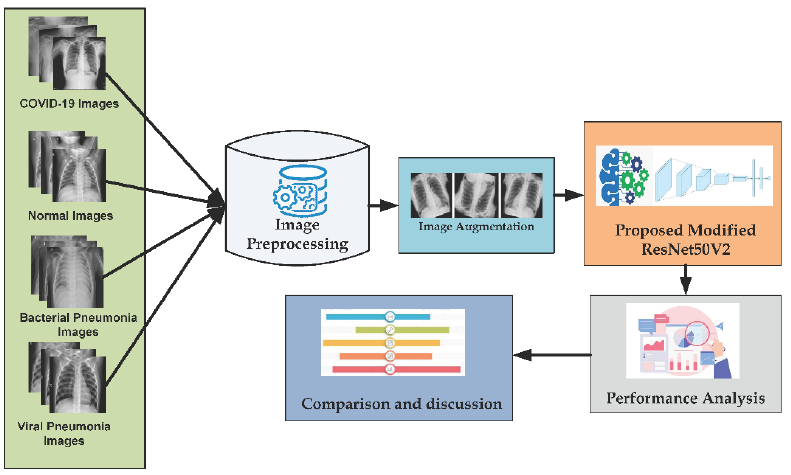
Figure 3. Overview of the proposed research